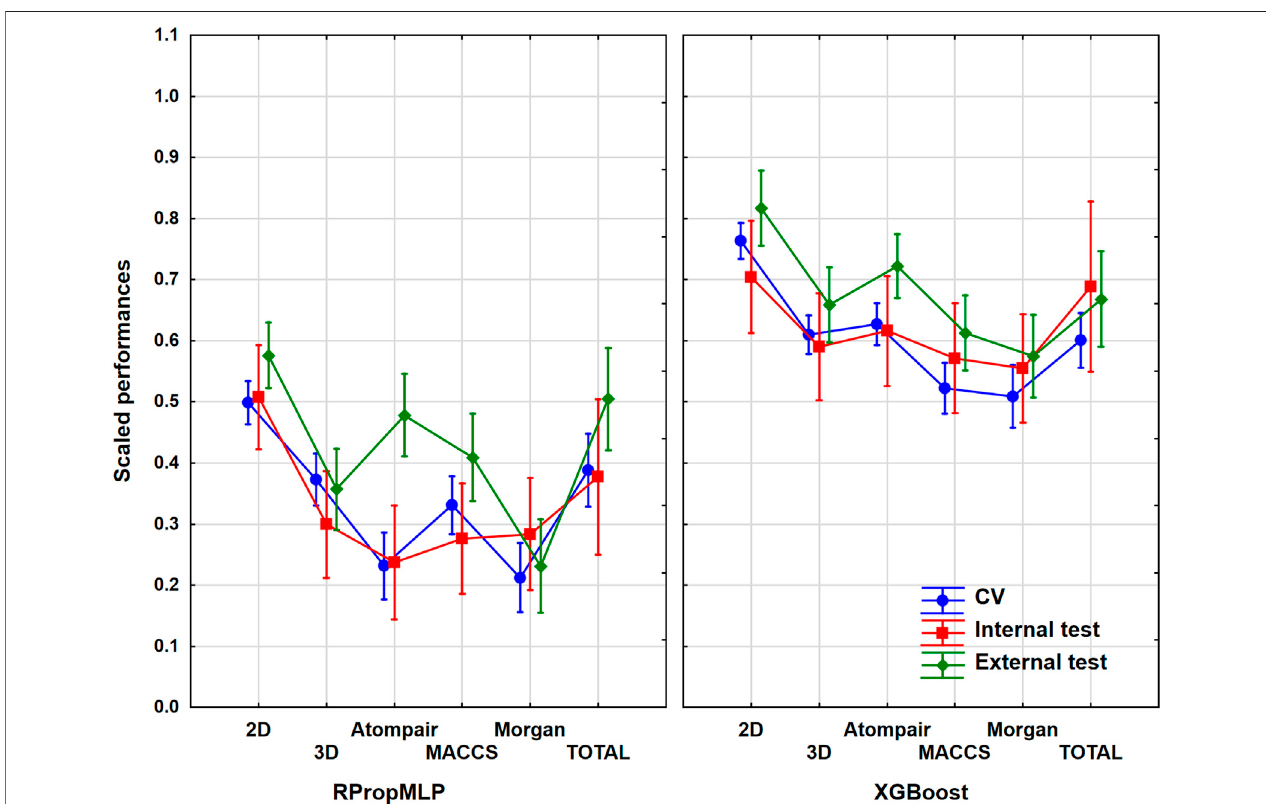
FIGURE 5 | Scaled performances in the case of hERG inhibition dataset based on the molecular descriptor types and machine learning algorithms. The 18 performanceparameterswererange-scaledbetween0and1andaveragedacrossallmodelswiththegivendescriptortypes/MLalgorithms.TheresultofCVismarked withblue,theinternaltestresultismarkedwithred,andtheexternaltestismarkedwithgreen.Themeanofthescaledperformancesisplottedineachcasewiththe95% con fi dence intervals.